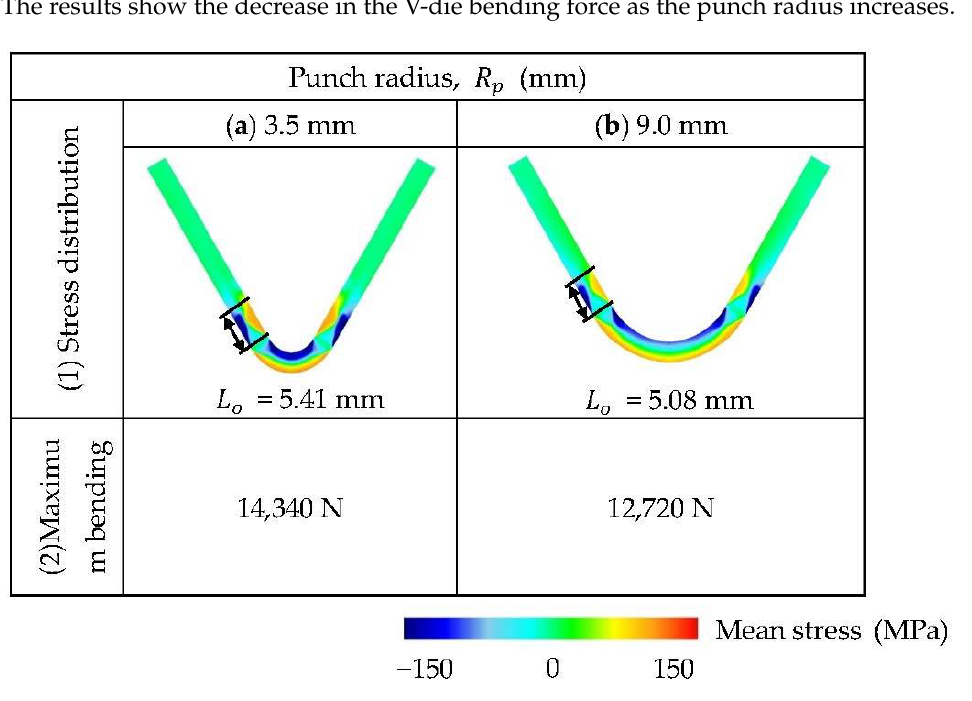
Figure 9. Illustration of stress distribution analyses and bending force with respect to punch radius ( 𝑇 = 3.0 mm, 𝜃 = 60°, AA1100-O, 𝐿 = 70 mm, l k = 60 mm).